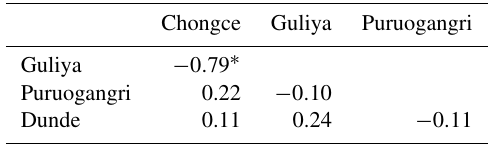
Table 1. Correlation coefficients ( n = 16) between the δ 18 O profiles of the Tibetan ice cores.